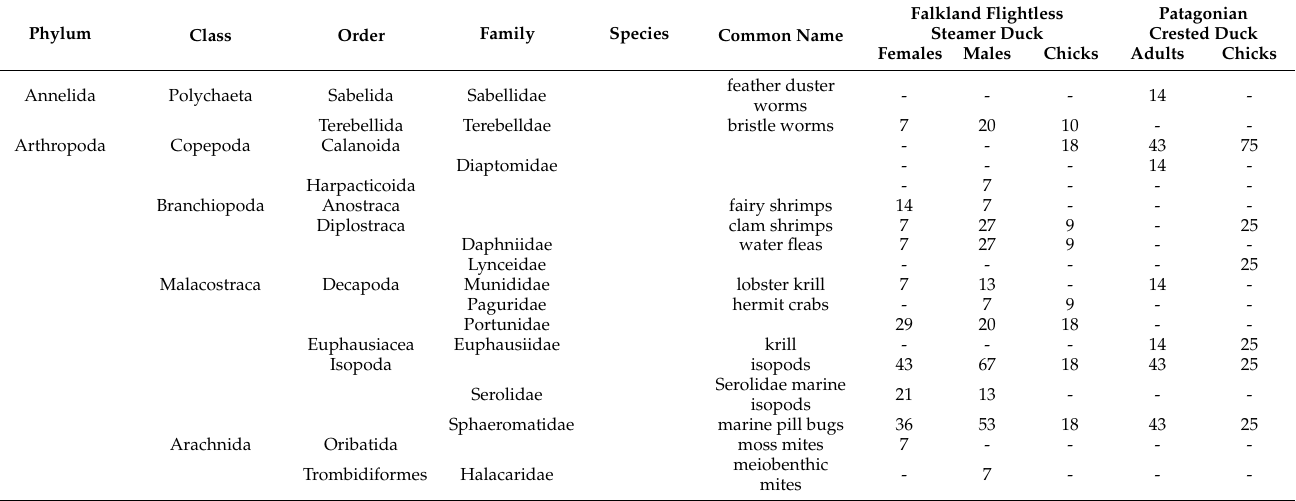
Table 2. Invertebrate and ascidian prey consumed by Falkland Flightless Steamer Duck Tachy- eres brachydactyla and Patagonian Crested Duck Lophonetta specularoides , and frequency of occurrence (% of